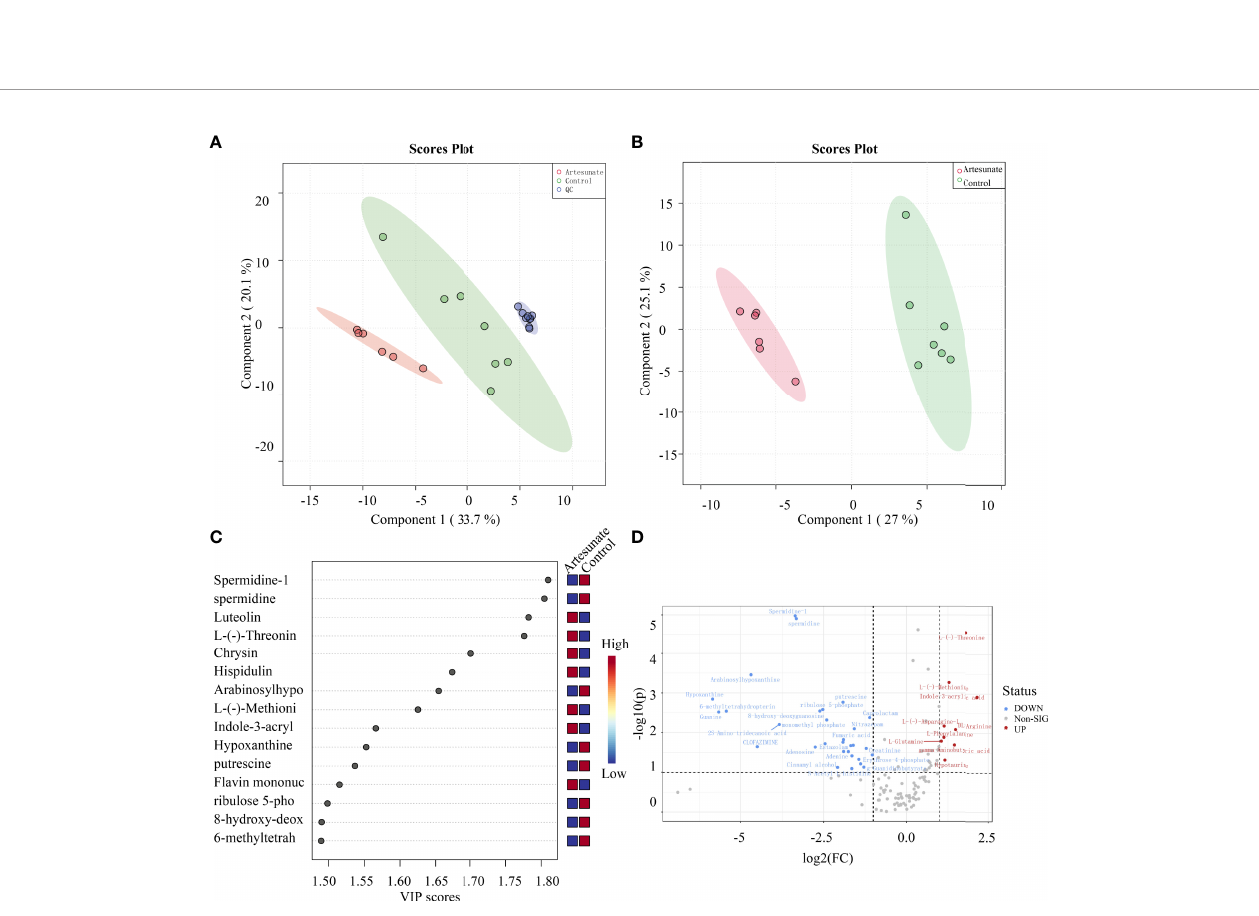
FIGURE 2 | The effect of artesunate on the metabolism of EC cells. (A) There was a clear trend of separation between the 3 m mol/L artesunate group samples and the control group samples. (B) QC samples showed good aggregation. (C) Scoring of differential metabolites by LS-PCA. (D) Metabolites with signi fi cantly different levels were analyzed by volcano graphs.